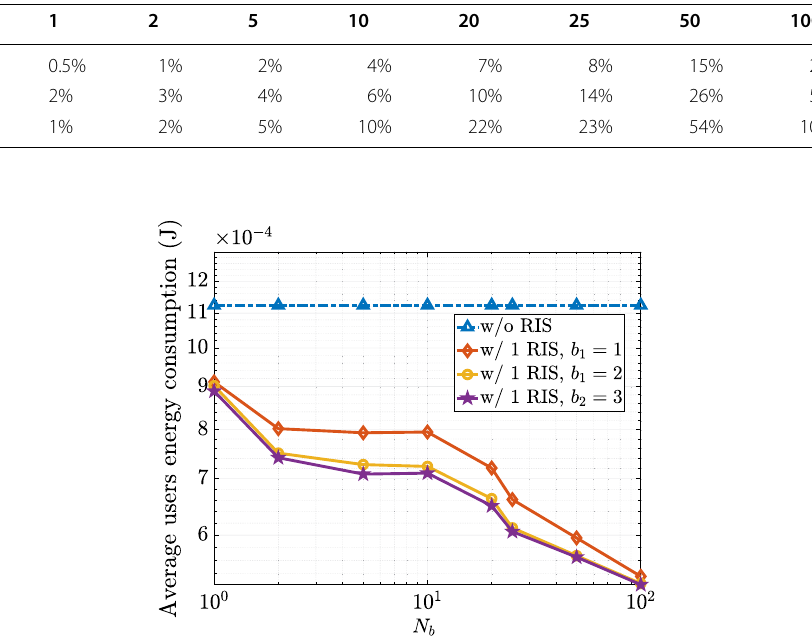
Table 1 Percentage of saved time with respect to full optimization